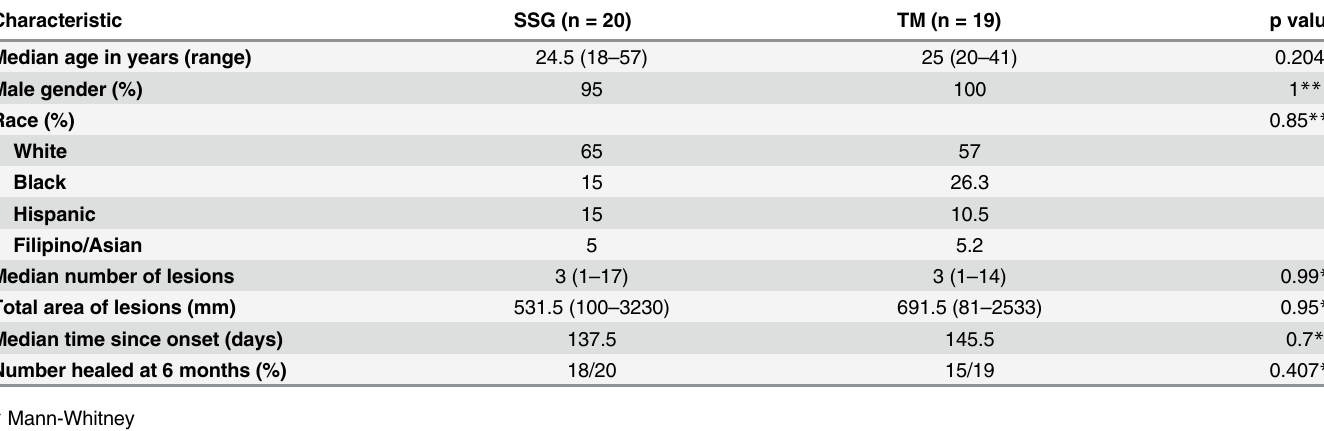
Table 1. Demographic characteristics and outcome presented by treatment arm.